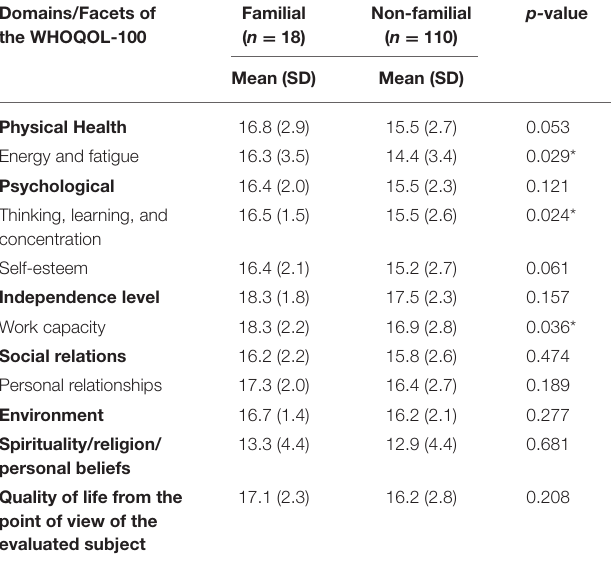
TABLE 3 | Generic quality of life in pediatric patients with Hirschsprung’s disease of the rectosigmoid. Domains of the CHQ-CF87 Familial